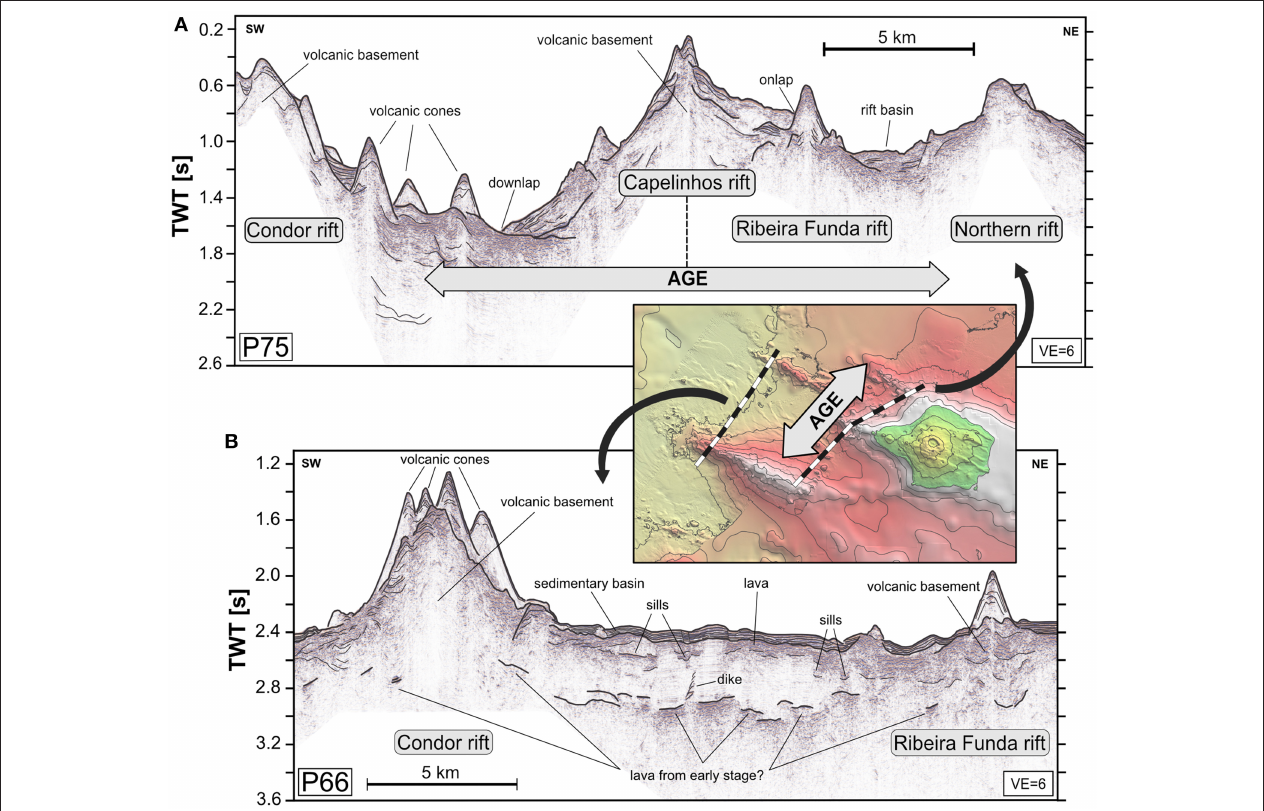
FIGURE 3 | Interpreted SW-NE seismic profiles across the rift zones with (A) proximal, and (B) distal relative to Faial. Inset map highlights the relative ages derived from seismic imagery, lines mark seismic profiles. Main seismic reflectors are marked with thick black lines. Note that the ages of the rift zones in (B) are increasing from Capelinhos rift toward Condor (SW) and Ribeira Funda rifts (NE) as illustrated by the double arrow in (A) and the inset map.